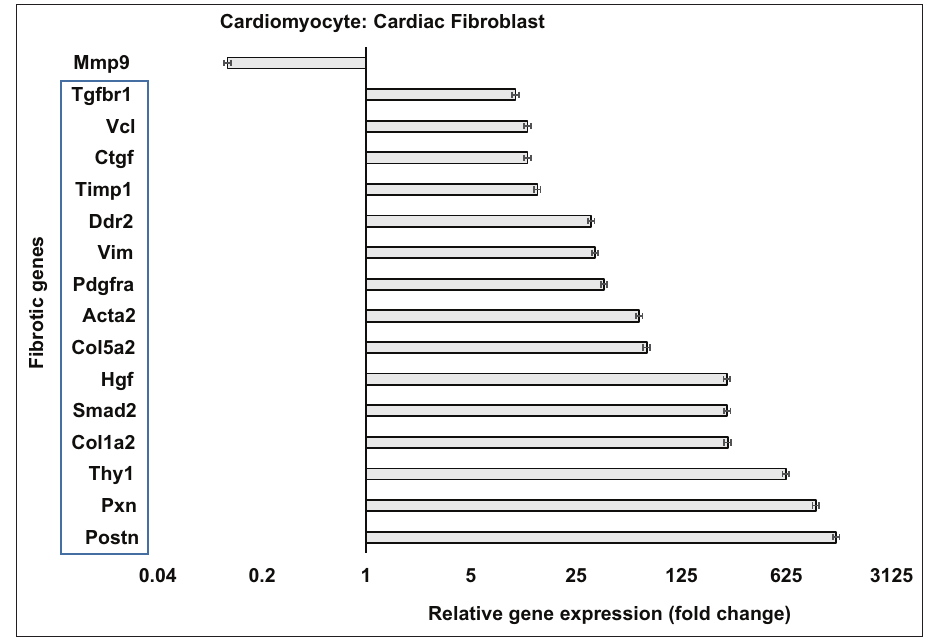
Figure-2: Fibrotic gene expression in cardiomyocytes compared to cardiac fibroblasts. Fifteen fibrotic genes (in the blue rectangle) had greater expression in cardiac fibroblasts than in cardiomyocytes (p<0.01). Matrix metallopeptidase 9 expression was significantly higher in cardiomyocytes than in cardiac fibroblasts (p<0.01). Cell culture was done in six replications while quantitative polymerase chain reaction was done in three replications.